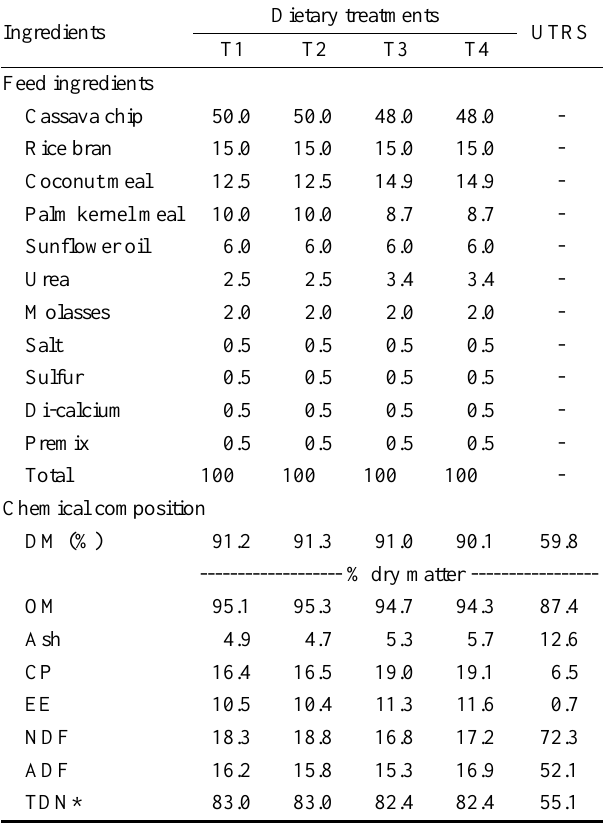
Table 1. Chemical composition of concentrate and urea-treated rice straw (UTRS) used in the experiment (% DM) Dietary Ingredients